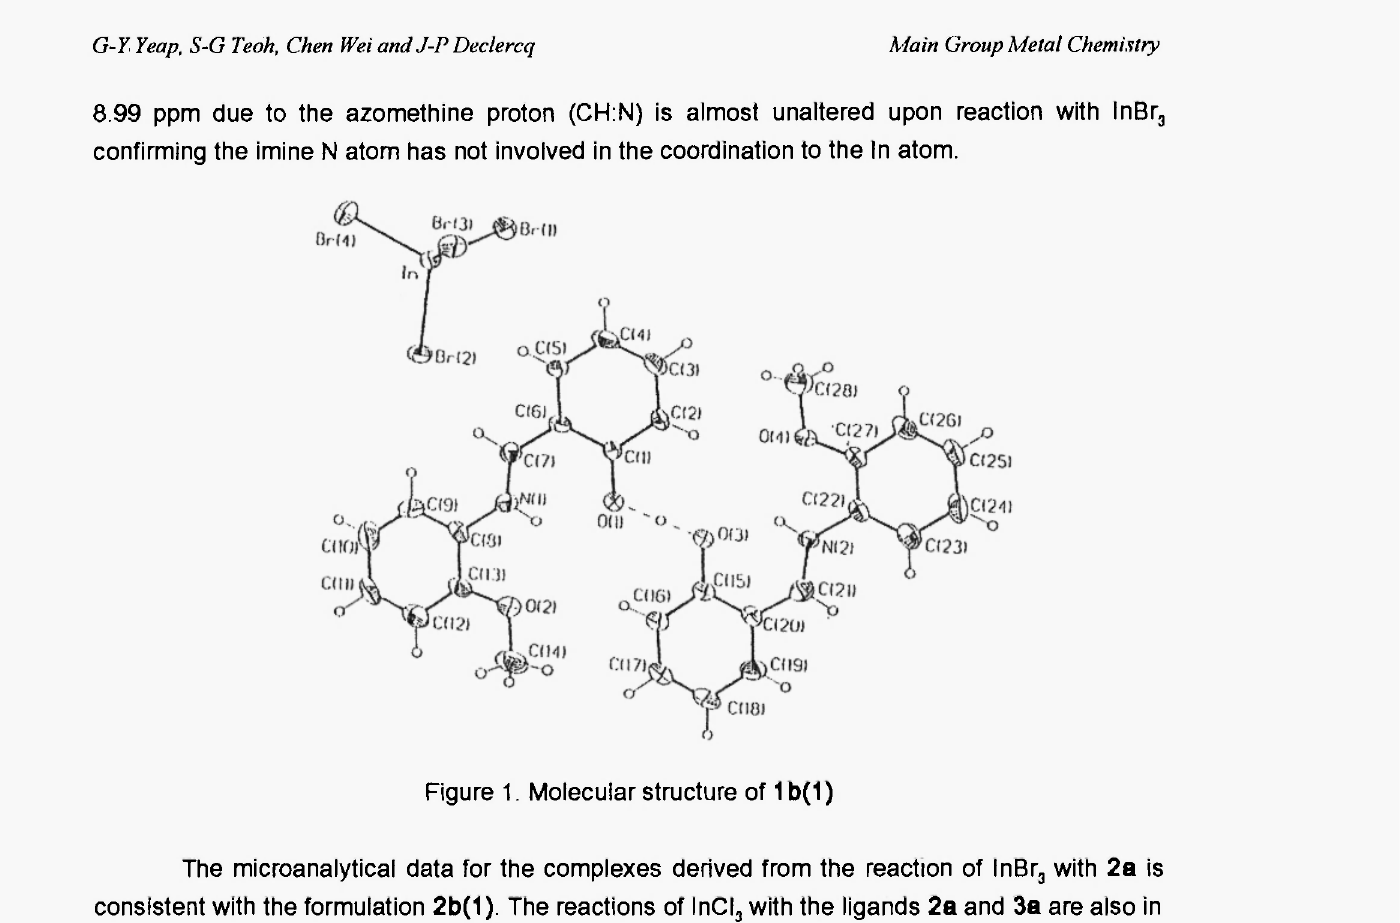
Figure 1. Molecular structure of